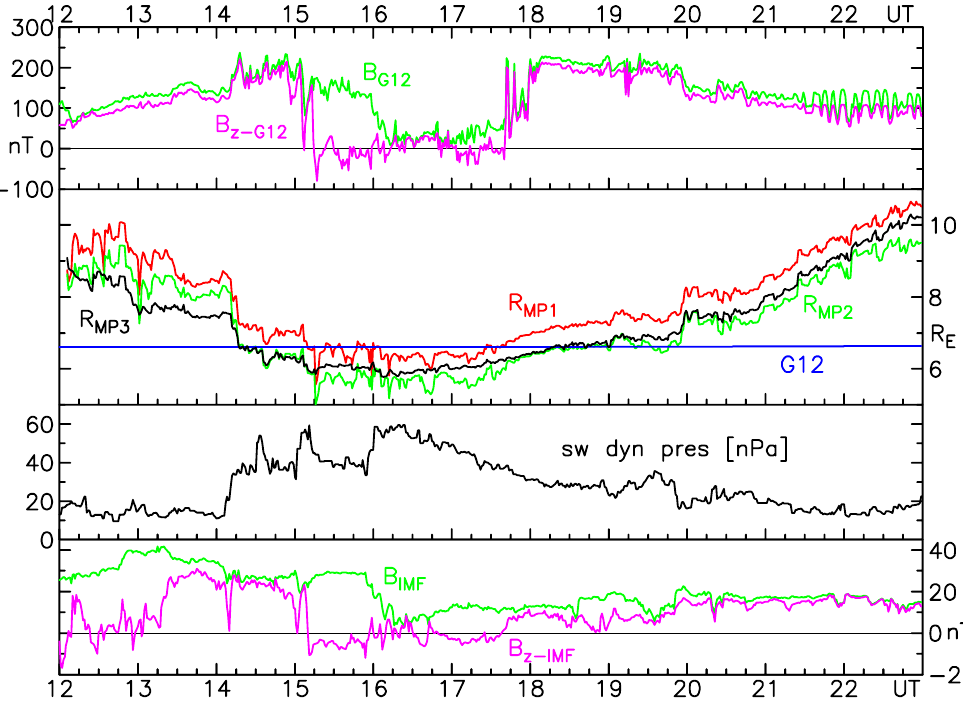
Fig. 1. 17 January 2005. Top panel: GOES 12 magnetic field observations: total value (green line), and B z in GSM coordinates (lilac). Panel 2: model magnetopause locations for angular directions corresponding to GOES 12 position: MP1 in red (Shue et al., 1998), MP2 in green (Lin et al., 2010), and MP3 in black (new model); G12 trajectory: blue line. Panel 3: solar wind dynamic pressure. Bottom panel: IMF: total field (green), and B z (lilac). Interplanetary data from Wind